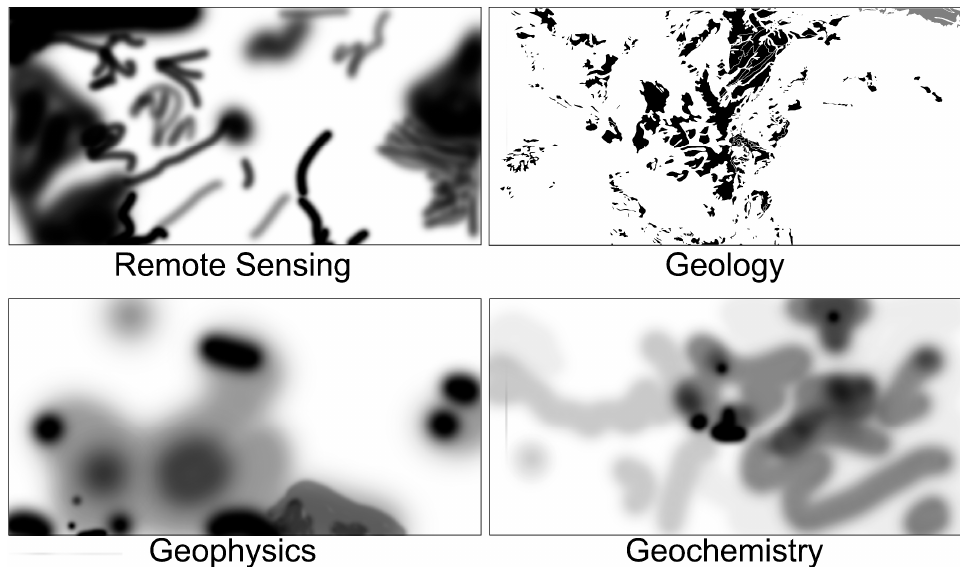
Figure 21. The fuzzified information layers for the study area. Figure 22 shows the metallic prospectivity map of the study area. As presented in the final prospectivity map, based on fuzzy logic, low potential areas are indicated with white to gray color and high potential areas tend to the black color.